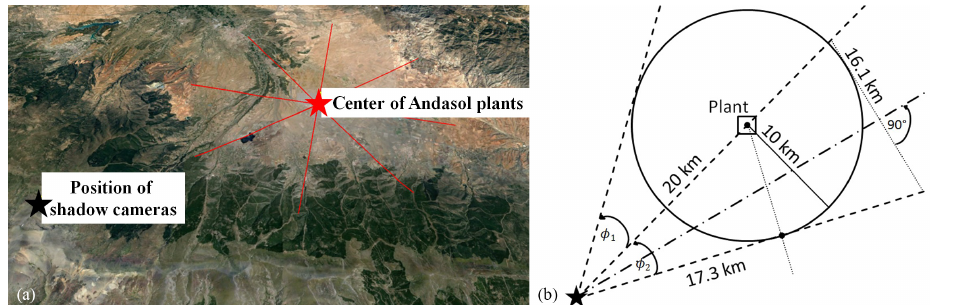
Figure 3. Case study of a potential shadow camera based nowcasting system for the Andasol solar power plants in Spain. (a) Red lines mark 10km distances around the plants’ centre. (Google Earth) (b) Geometry and distances. The cameras’ hypothetical position (37 ◦ 7 (cid:48) 27.15"N, 3 ◦ 15 (cid:48) 6.72"W) is marked with a